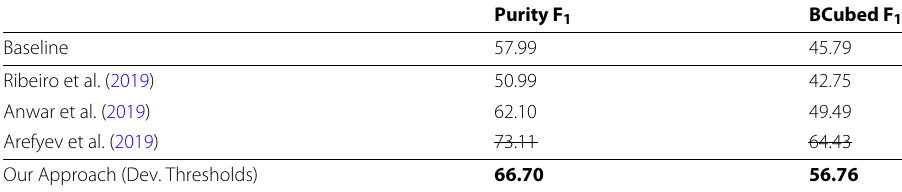
Table 13 Comparison of semantic frame slot induction results with those of previous approaches in terms of performance on the test data